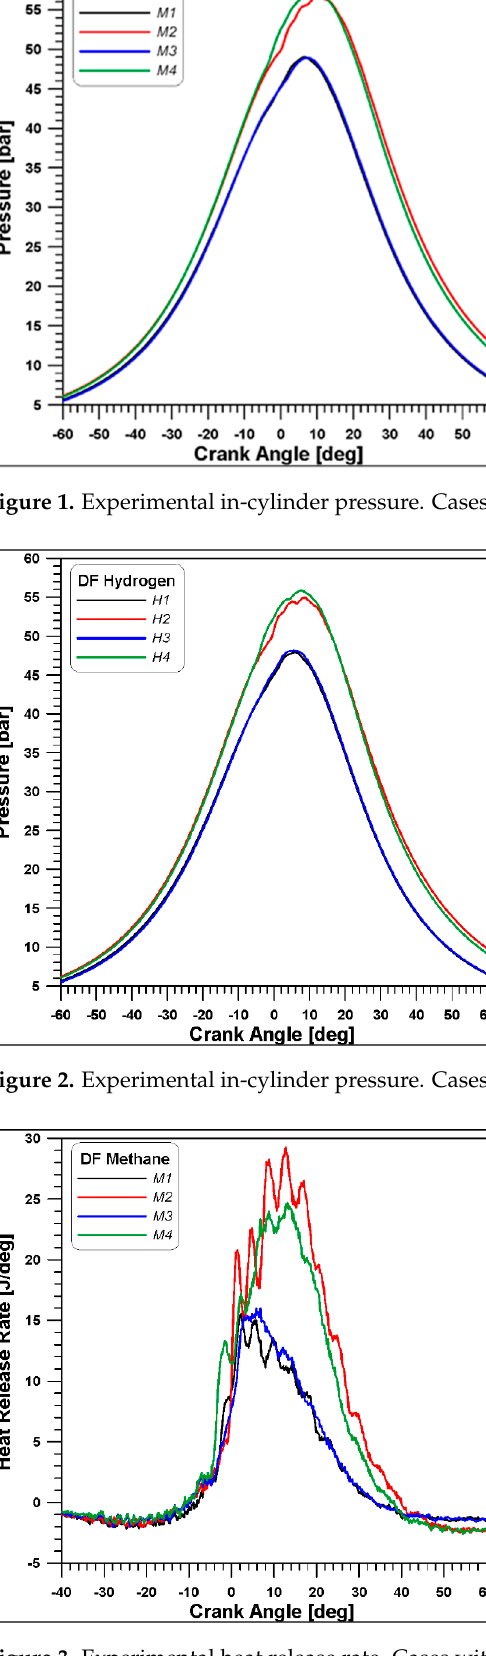
Figure 4. Experimental heat release rate. Cases with hydrogen. The accumulated heat release rate diagrams (Figures 5 and 6) confirm this trend, showing how cases with higher energy inputs correspond to the major final values of the total energy. Finally, a comparison between the case M3 (methane) and H4 (hydrogen) is reported in Figure 7. These two cases are taken as the basis for a first comparison since they have the same engine speed, and the values of the equivalence ratio and RP are very similar. For a better comparison, the graph of the heat release rate is normalized with respect to the total fuel energy.